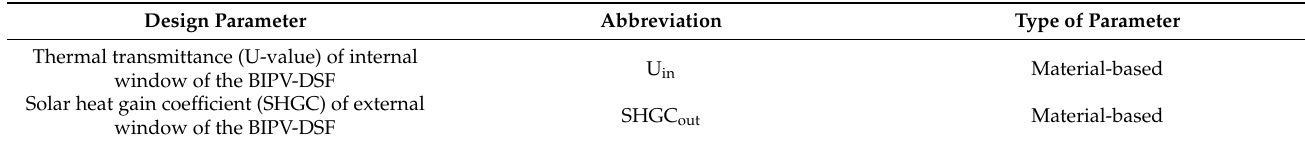
Table 1. Summary of most important design parameters based on sensitivity analysis.